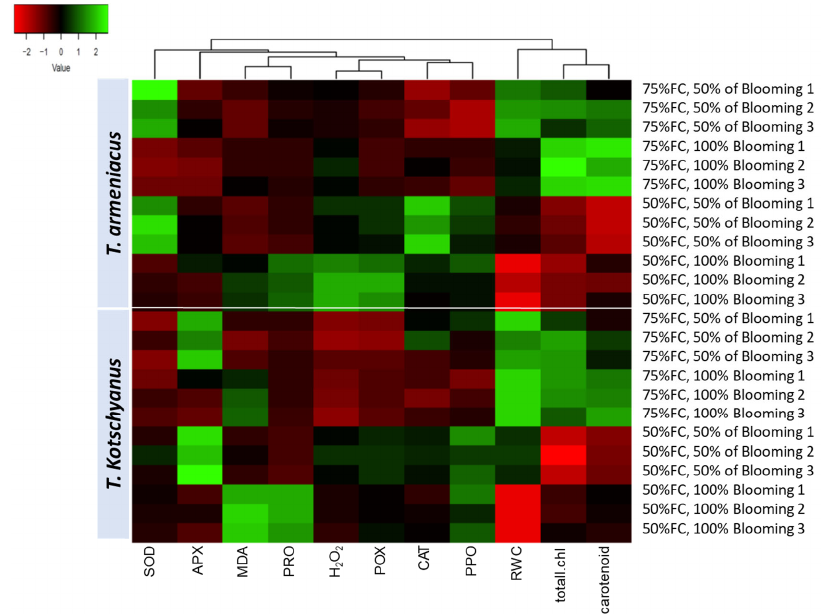
Figure 3. Heatmap of standardized values indicating physiological trait regulation across treat ‐ ments. The effect of irrigation regime (75 or 50% of field capacity) on several physiological traits (data in Table 6) of two Thymus species ( T. armeniacus , T. kotschyanus ) was investigated at two de ‐ velopmental stages (50 and 100% blooming). Color may indicate up ‐ or downregulation (green and red, respectively). A scale of intensity is